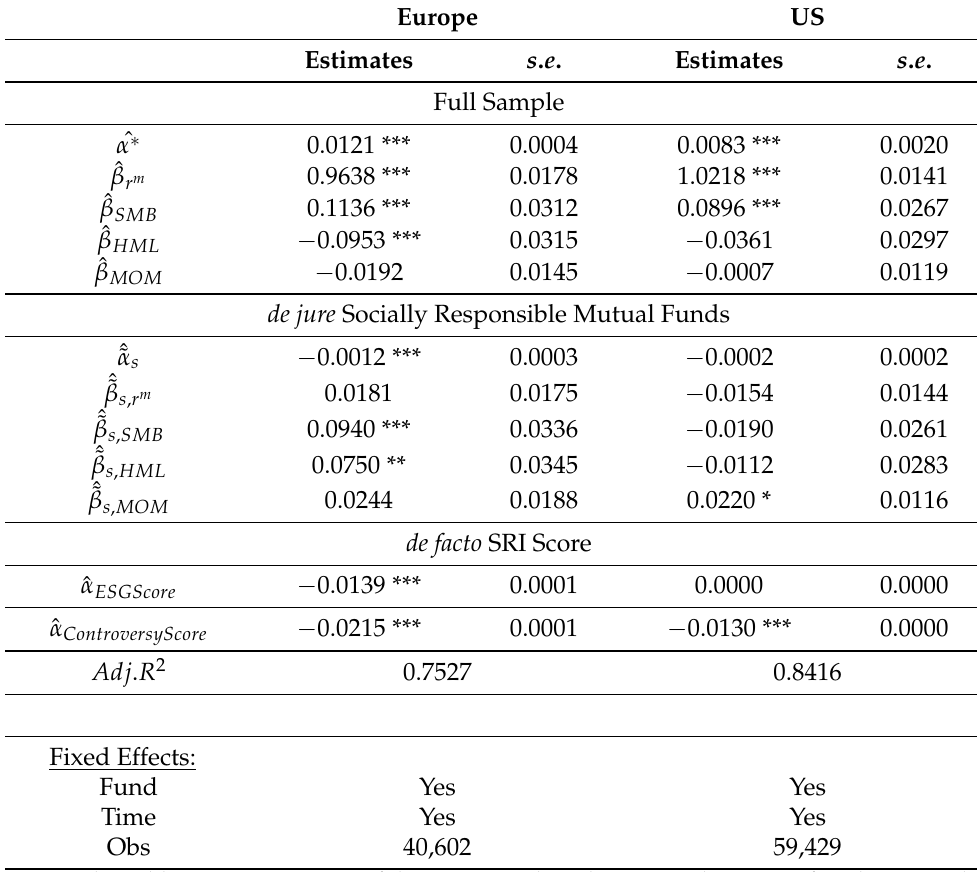
Table 10. Estimation of the augmented nonlinear panel version of Carhart’s model (2013–2018) with ESG and Controversy